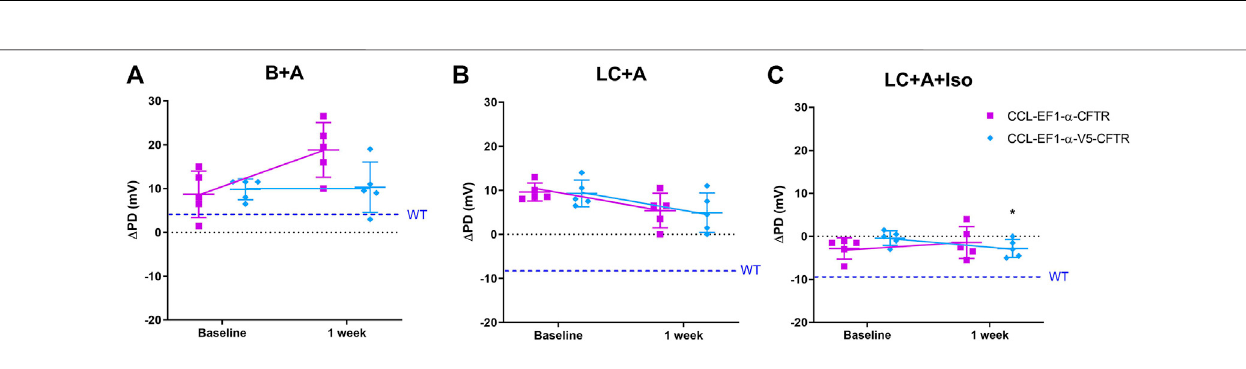
Frontiers in Pharmacology |